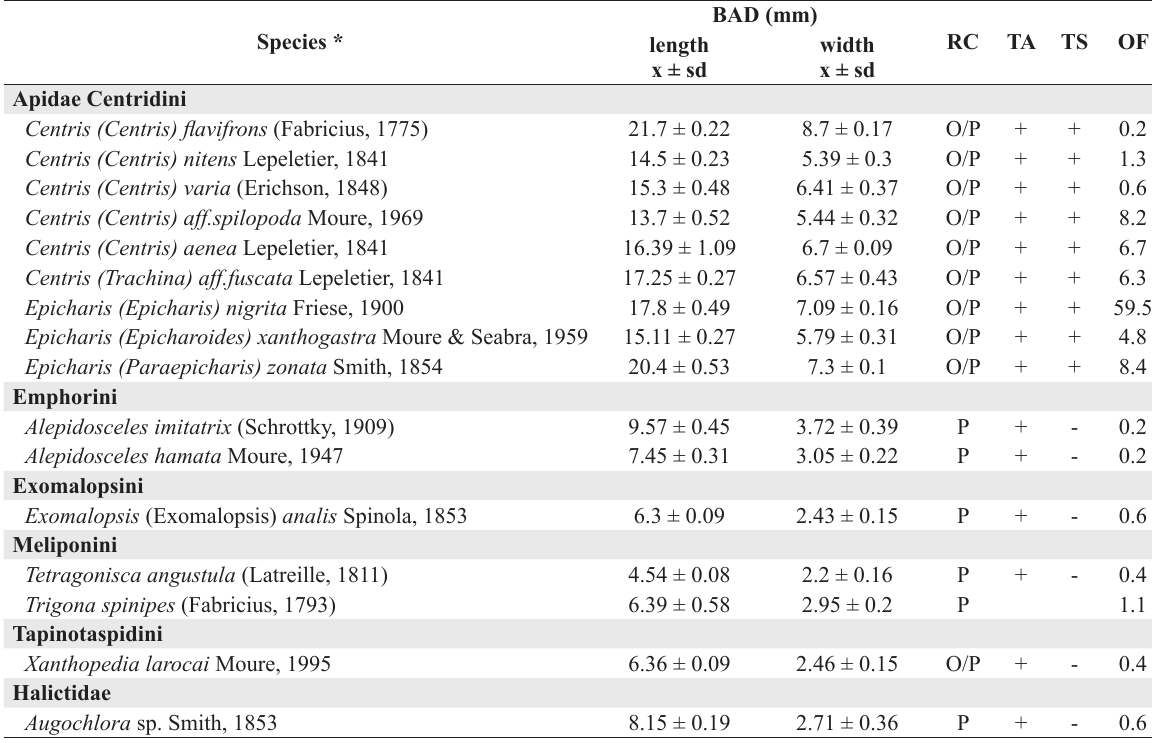
Floral visitors of Byrsonima cydoniifolia in Pantanal sub-region of Miranda, Mato Grosso do Sul. BAD = Body approximate dimension; ± sd = mean ± standard deviation; RC = Resource collected; O = Oil; P = Pollen; TS = touched stigma; TA=touched anthers; OF = Occurrence frequency - less